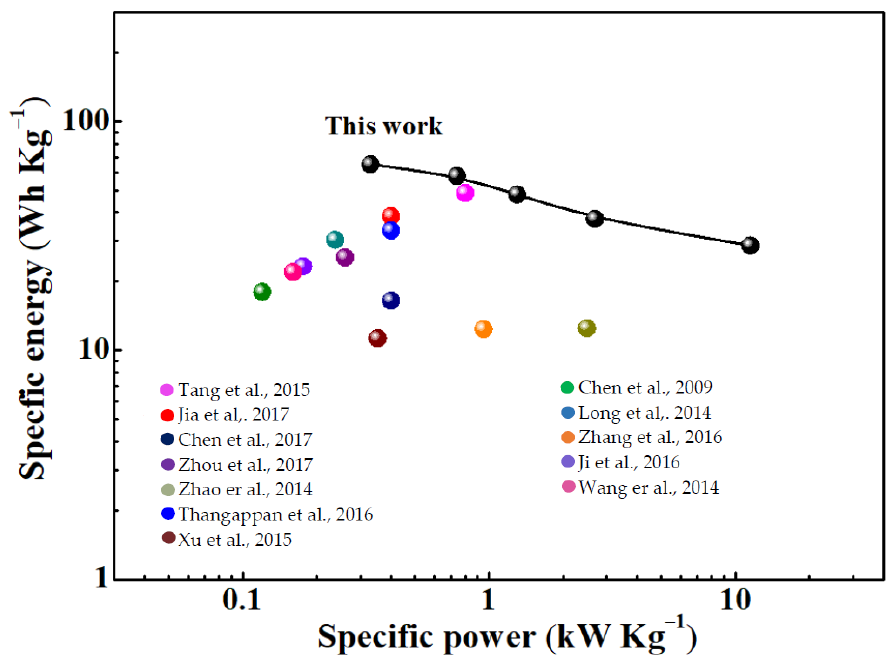
Figure 5. Ragone plots (power density vs. energy density) of the flexible ASC device.